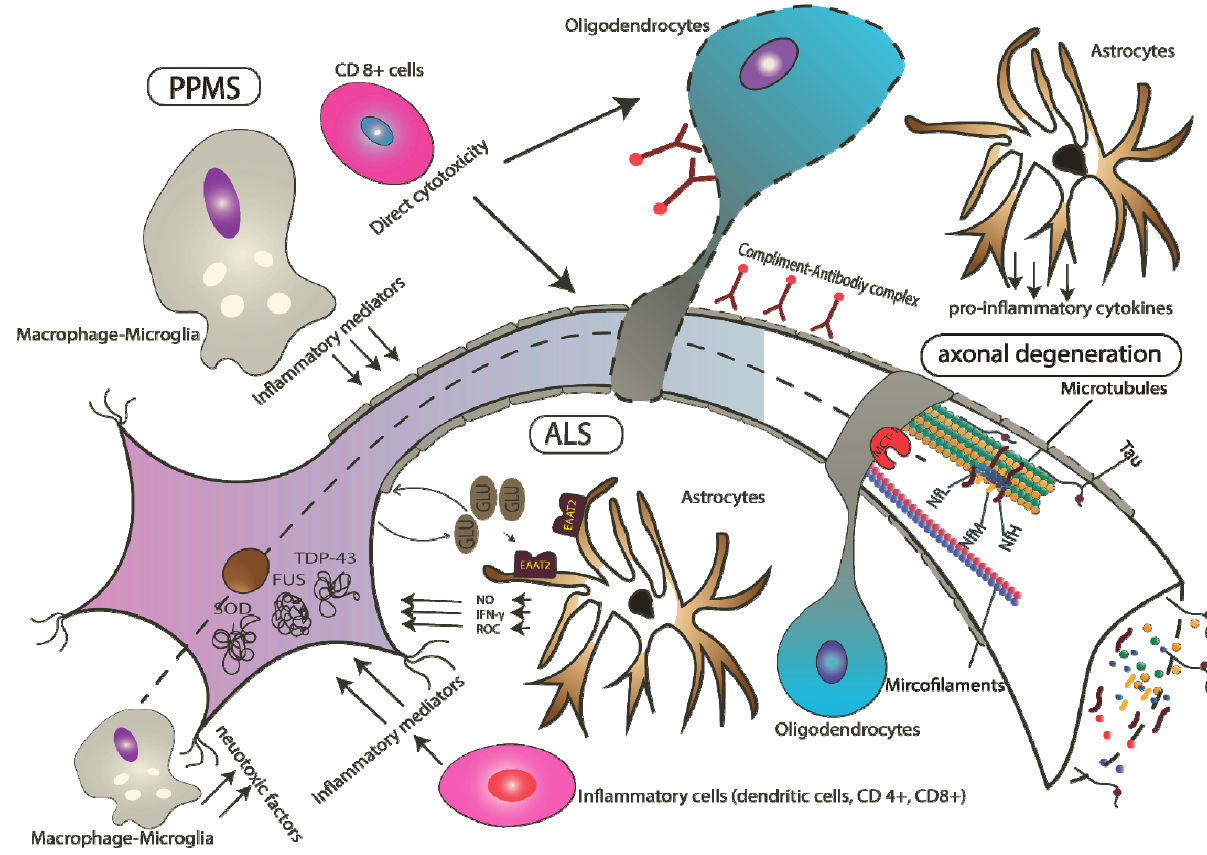
Figure 1. Main pathophysiological processes involved in Amyotrophic lateral sclerosis (ALS) and primary progressive multiple sclerosis (PPMS). ALS is characterized by accumulation of intracellular cytoplasmic aggregations (TDP-43, fused in sarcoma (FUS) and superoxide dismutase (SOD)) in the motor neurons. Glial cells play an important role in the pathophysiology through different pathways: defective astrocytic glutamate (GLU) uptake through excitatory amino acid transport (EAAT)-2 receptors resulting in glutamate excitotoxicity, defective lactate uptake by the oligodendrocytes through monocarboxylate transporter (MCT)-1 receptors and neurotoxic factors release from the microglial cells. Inflammatory cells like dendritic cells play a role through release of inflammatory mediators like interferon- γ (IFN- γ ), reactive oxygen species (ROS) and nitric oxide (NO). In PPMS, however, the axonal loss is mediated by different mechanisms like macrophage and T-cell induced tissue damage, antibodies mediated damage of the myelin sheath and oligodendrocytes, hypoxic tissue injury and primary oligodendrocyte’s susceptibility. Both diseases result in axonal damage with increased levels of different markers in the cerebrospinal fluid (CSF) (total Tau-protein (t-Tau), phosphorylated Tau-protein (p-Tau), neurofilaments, actin and tubulin) and characteristic changes in magnetic resonance imaging (MRI) like brain atrophy and reduction of fractional anisotropy